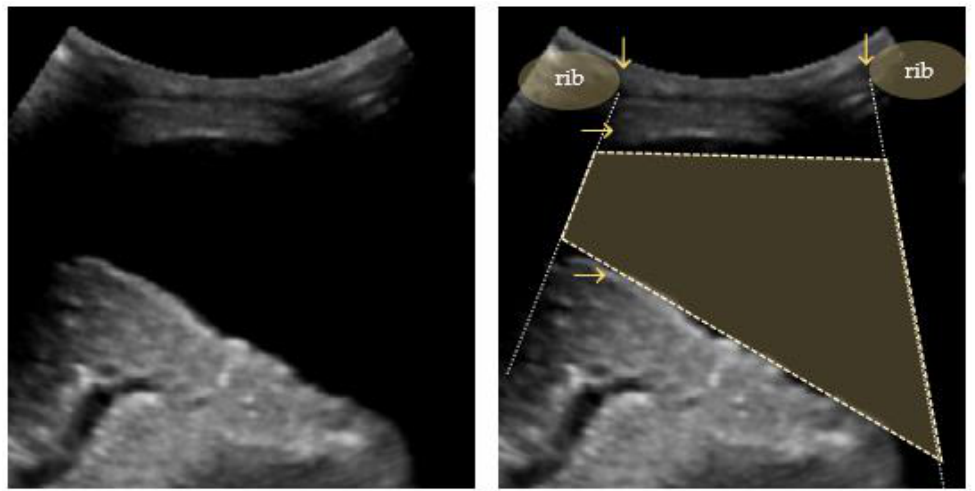
Figure 7. Quad sign: trapezium shaped pleural effusion (outlined) defined by the pleural and lung lines (horizontal arrows) and the shadows from the adjacent ribs (vertical arrows).